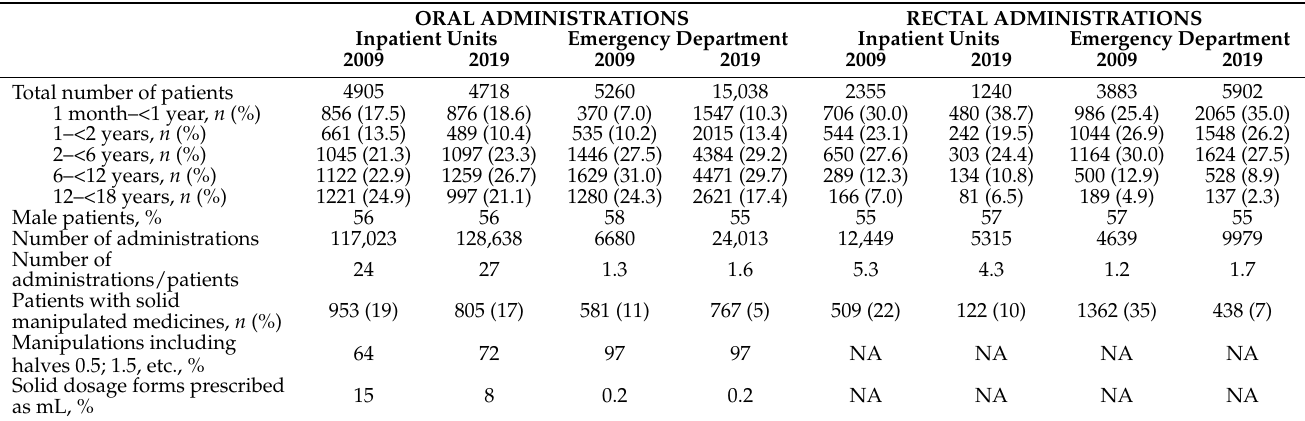
Table 1. Background data and main results.